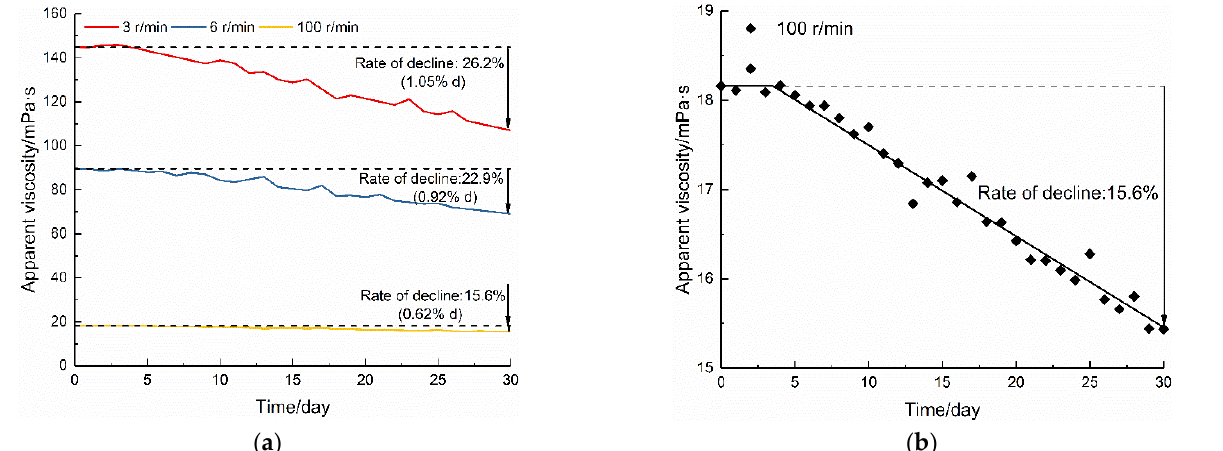
Figure 4. Viscosity-time profiles for polymer fluids: ( a ) different rotor speeds; ( b ) at 100 r/min.